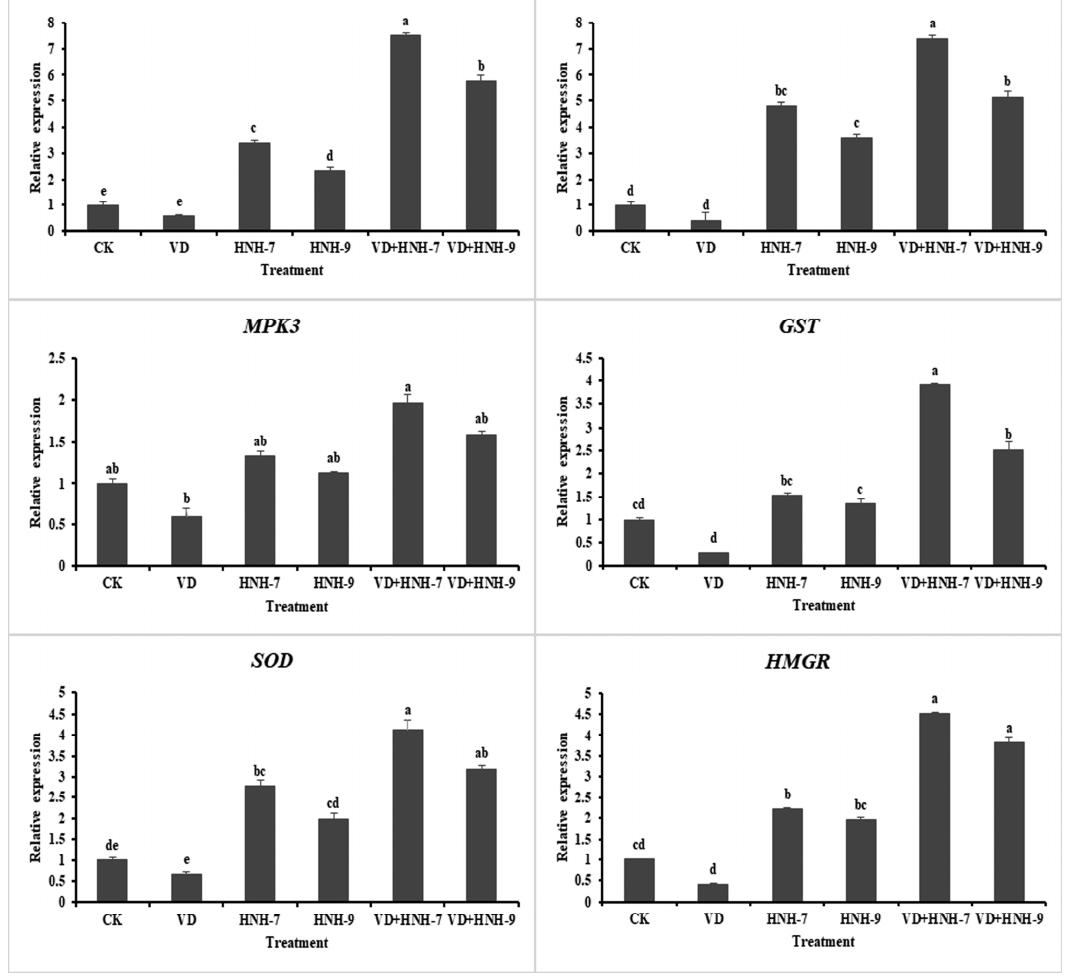
Figure 9. Expression profiling of 6 defense-linked genes in cotton was upregulated in treatments with the isolates. The mean values were computed and separated by LSD test at p ≤ 0.05 after one-way ANOVA. The error bars indicate the standard error ± SE of the mean values. Letters above the columns (a-e) represent significant differences between treatment means at p ≤ 0.05.